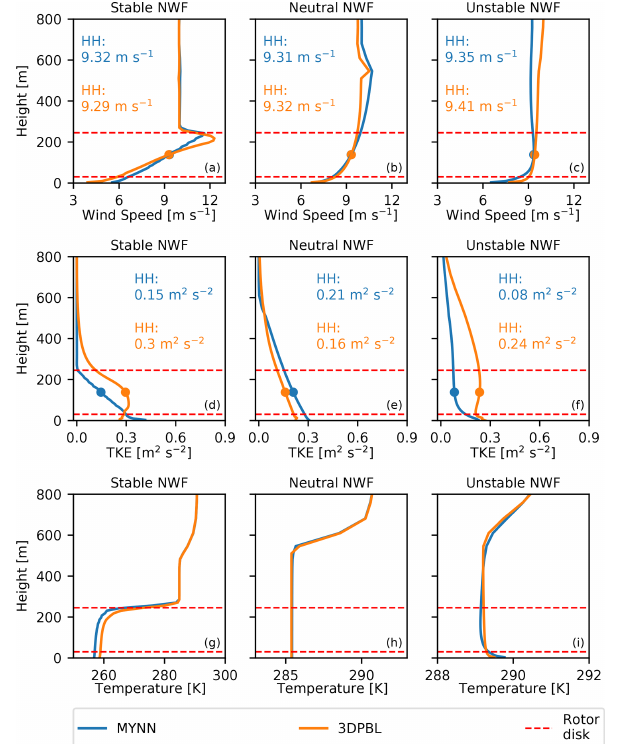
Figure 2. Averaged wind speed profiles (a–c) , TKE profiles (d–f) , and temperature profiles (g–i) in different stabilities for the ideal- ized NWF runs. Profiles have been horizontally averaged over the extent of the plant and time-averaged over the 24h performance period. Hub-height values of wind speed and TKE for each PBL scheme are